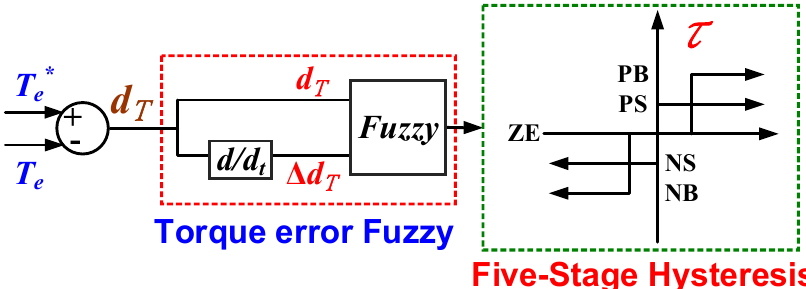
Figure 7. Torque error fuzzy controller with five-stage hysteresis control.